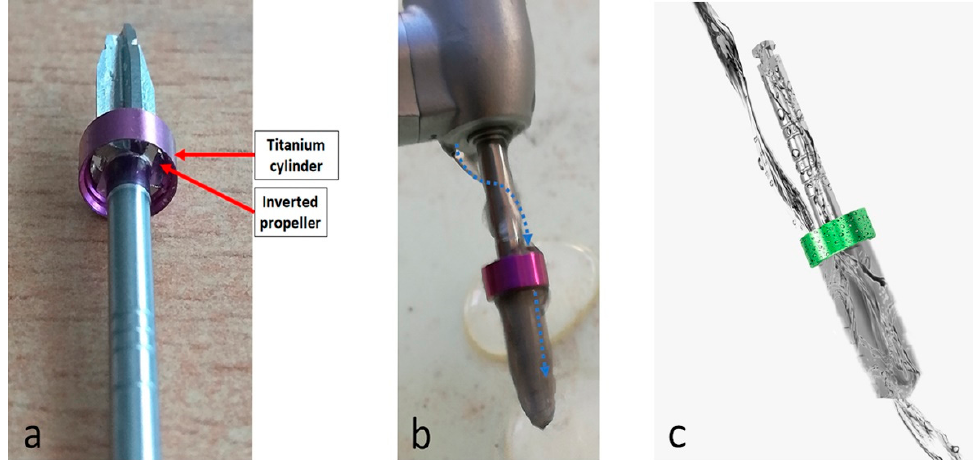
Figure 1. Representative image of the details of new drill design ( a ), that present an accoupled cylinder with an inverted propeller to improve the irrigation. ( b ) The blue arrows indicate the liquid is driven by the propeller down into the blades. ( c ) Schematic image of the path taken by the irrigating liquid.